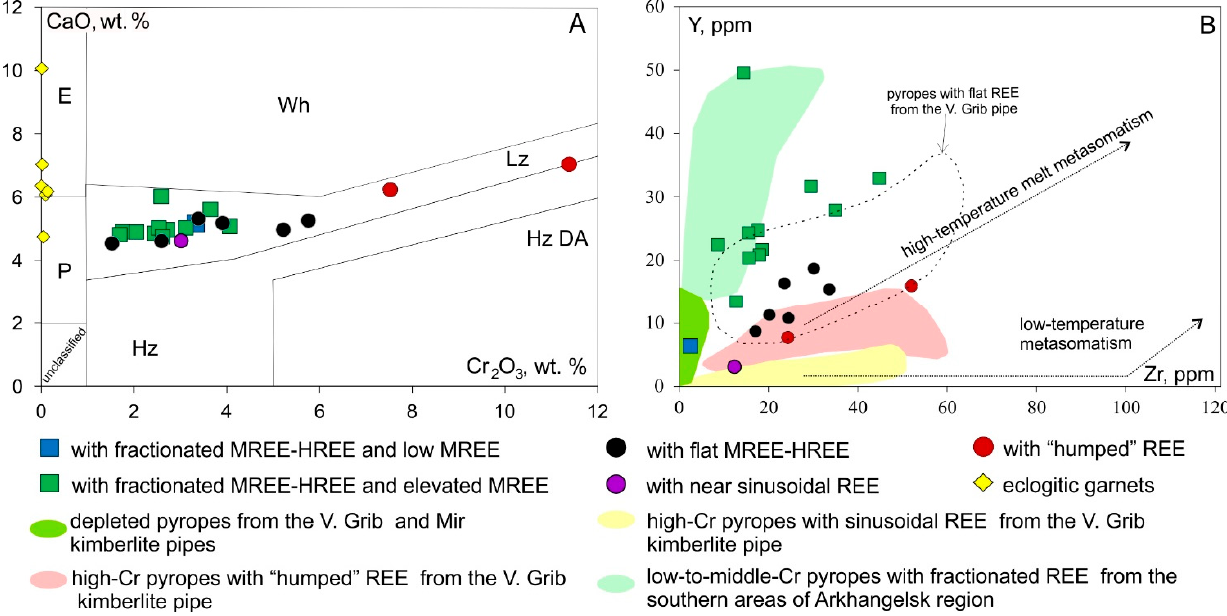
Figure 9. CaO-Cr 2 O 3 ( A ) and Y/Zr ( B ) variations in garnet xenocrysts from the KL-01 pipe. Harzburgite (Hz), Harzburgite diamond association (Hz DA), lherzolite (Lz), wehrlite (Wh) fields, after [30]. Eclogite (E), pyroxenite (P) and “unclassified” fields, after [28]. Pyropes from the V. Grib kimberlite pipe [32,33], Mir kimberlite pipe [34], southern areas of the Arkhangelsk region [3]. Trends of high- and low-temperature metasomatism [36]. M—middle, H—heavy, REE—rare earth